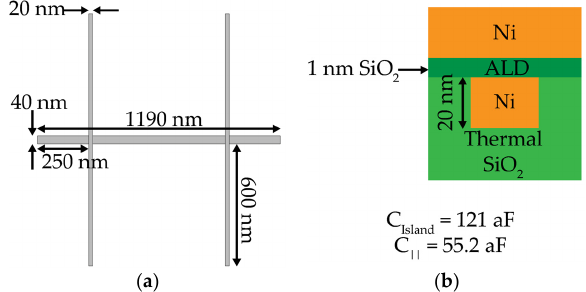
Figure 16. 3D simulation of the total island capacitance in a half ‐ damascene geometry: ( a ) Dimensions of the island (horizontal grey line) and source and drain (vertical grey lines). The island is inlaid in thermal SiO 2 ( ε = 3.9) and the source and drain are on top of the PEALD dielectric layer ( ε = 3.9) surrounded by air ( ε = 1); ( b ) Cross section of island inlaid in SiO 2 dielectric. The simulated total island capacitance C Island is for 1 nm of PEALD SiO 2 (approximately the same thickness as 12 cycles of SiO 2 , ε = 1). C ‖ is the expected island capacitance using the parallel plate model of the two tunnel junctions for the given dimensions. Based on our simulations, the actual island capacitance can be more than twice the calculated value using the parallel plate